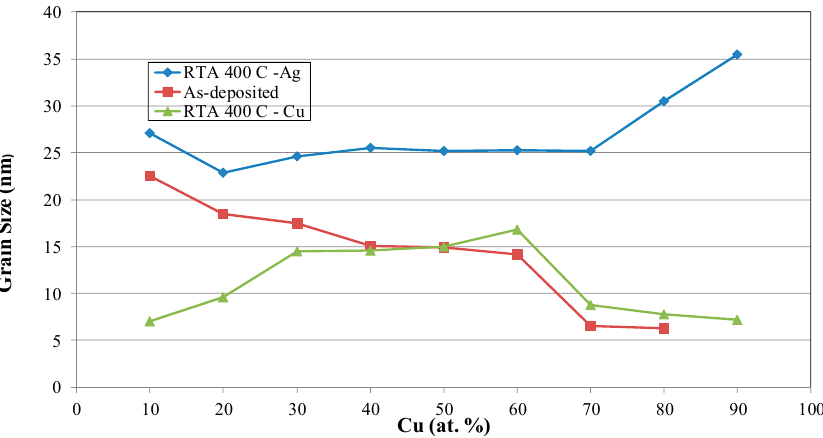
Figure 4. Calculated Ag and Cu grain sizes in Cu–Ag films, before and after annealing.